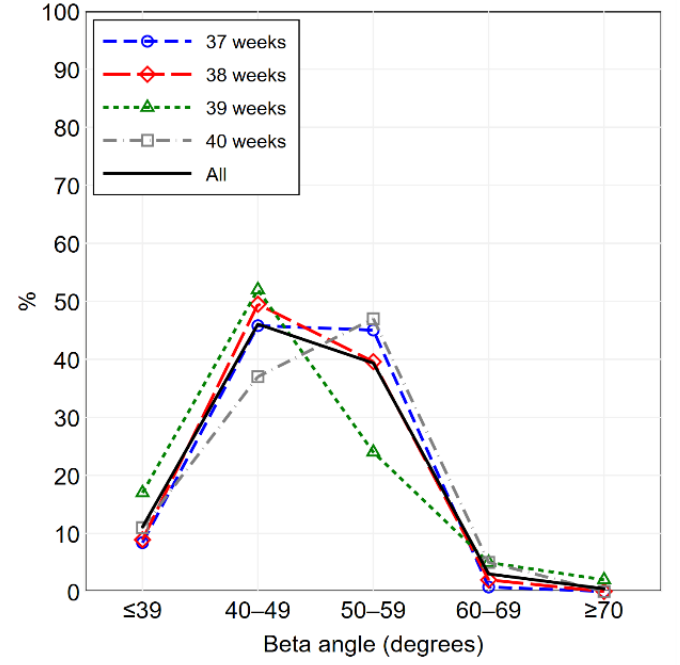
Figure 2. Alpha-angle frequency polygon, overall and by gestational age (37 weeks: n = 131; 38 weeks: n = 101; 39 weeks: n = 100; 40 weeks: n = 100).